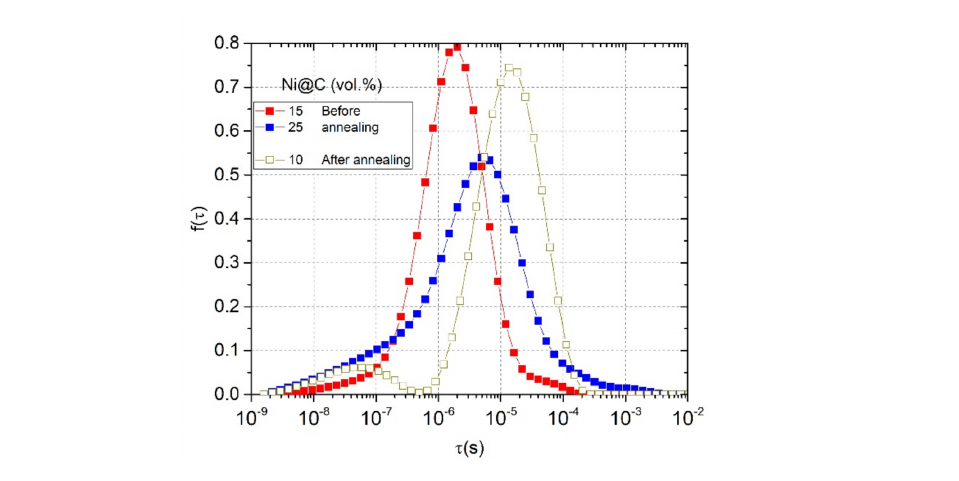
Figure 9. Relaxation time distributions (calculated according to Equation (4)) for mono-filled Ni@C/epoxy composites before and after annealing at 500 K.